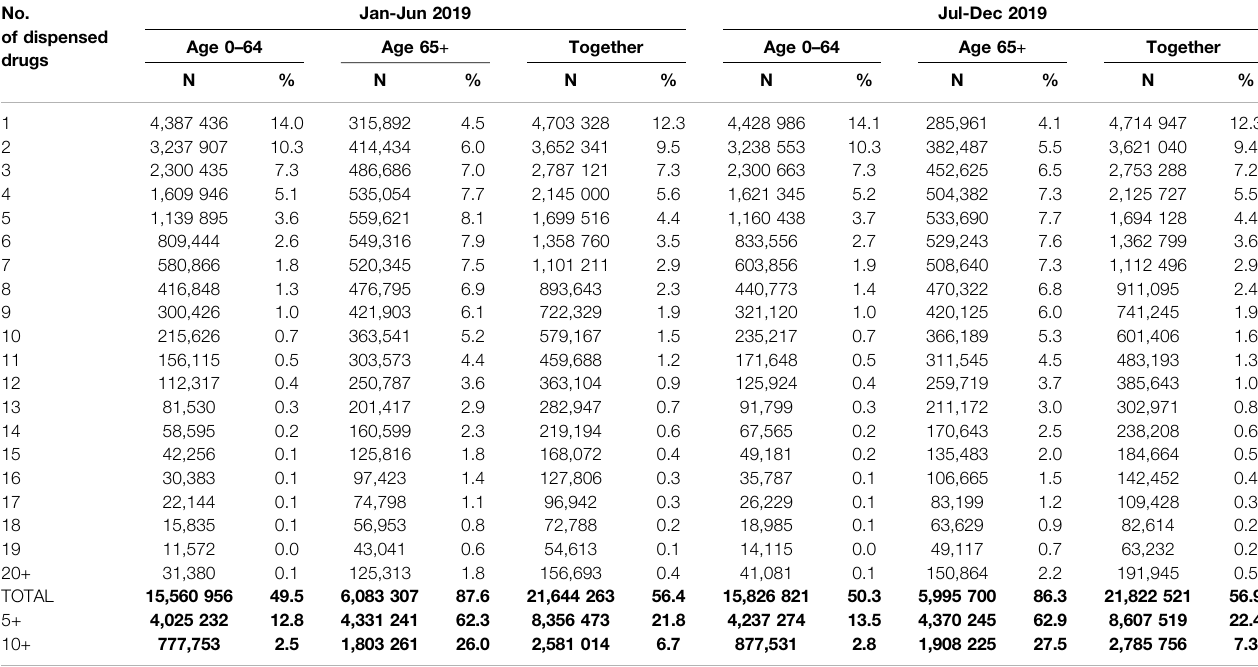
TABLE 1 | Age distribution of individuals dispensed various number of drugs holding various active substances according to prescriptions for both reimbursed and non- reimbursed drugs in half-year periods of 2019 in Poland. No. of dispensed drugs